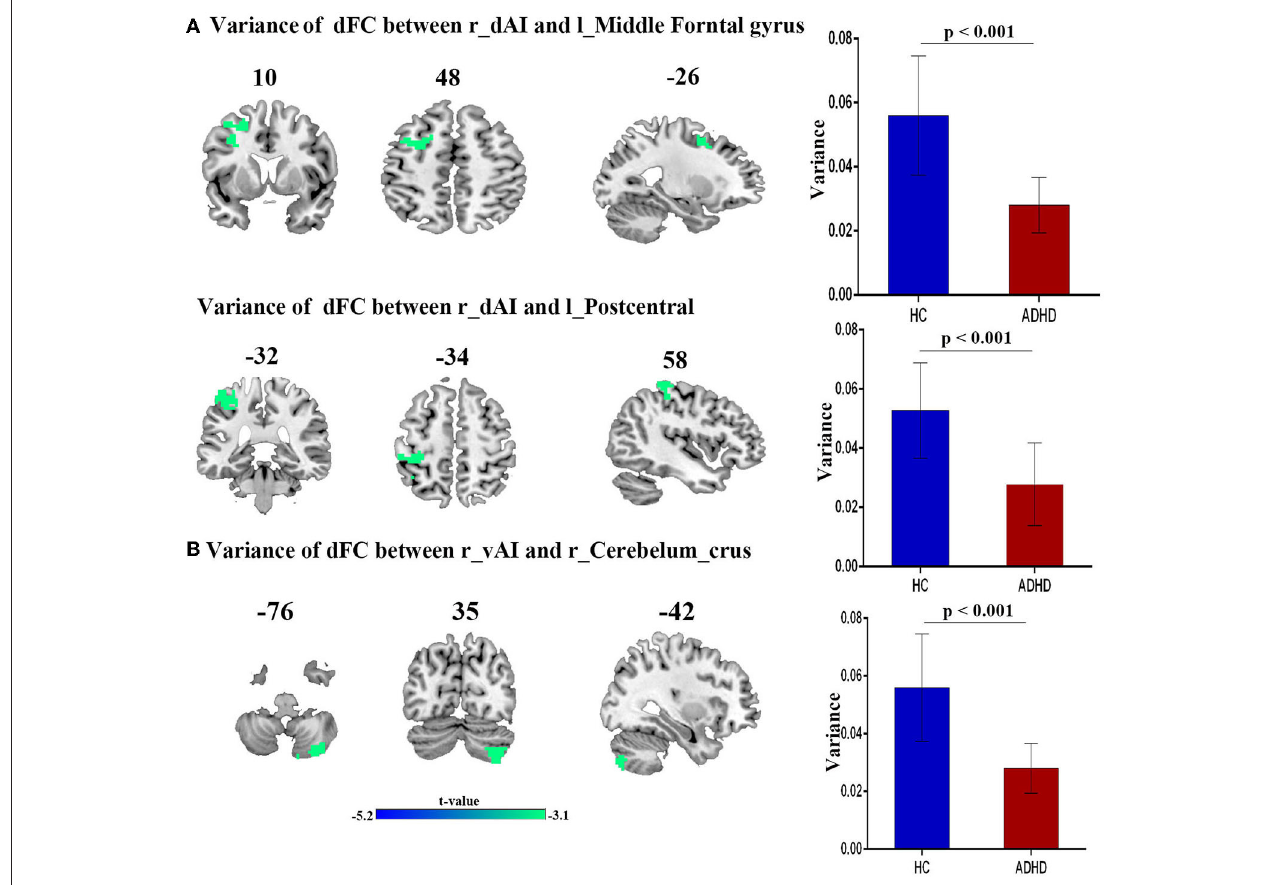
FIGURE 2 | The variance of dFC between the right insula and other brain regions, obtained by comparing HCs and ADHD groups, using two sample t -test; (A) Between right dAI and Left Middle frontal gyrus (first row) and Left postcentral gyrus (second row). (B) Between right vAI and right cerebelum